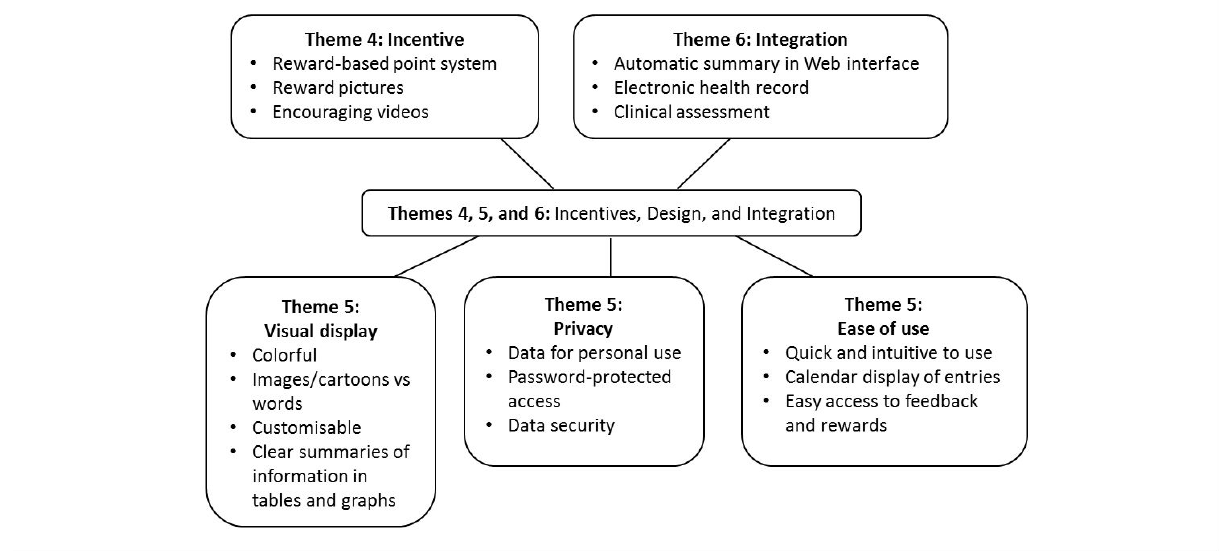
Figure 5. Results of content analysis of transcripts from focus groups for phase